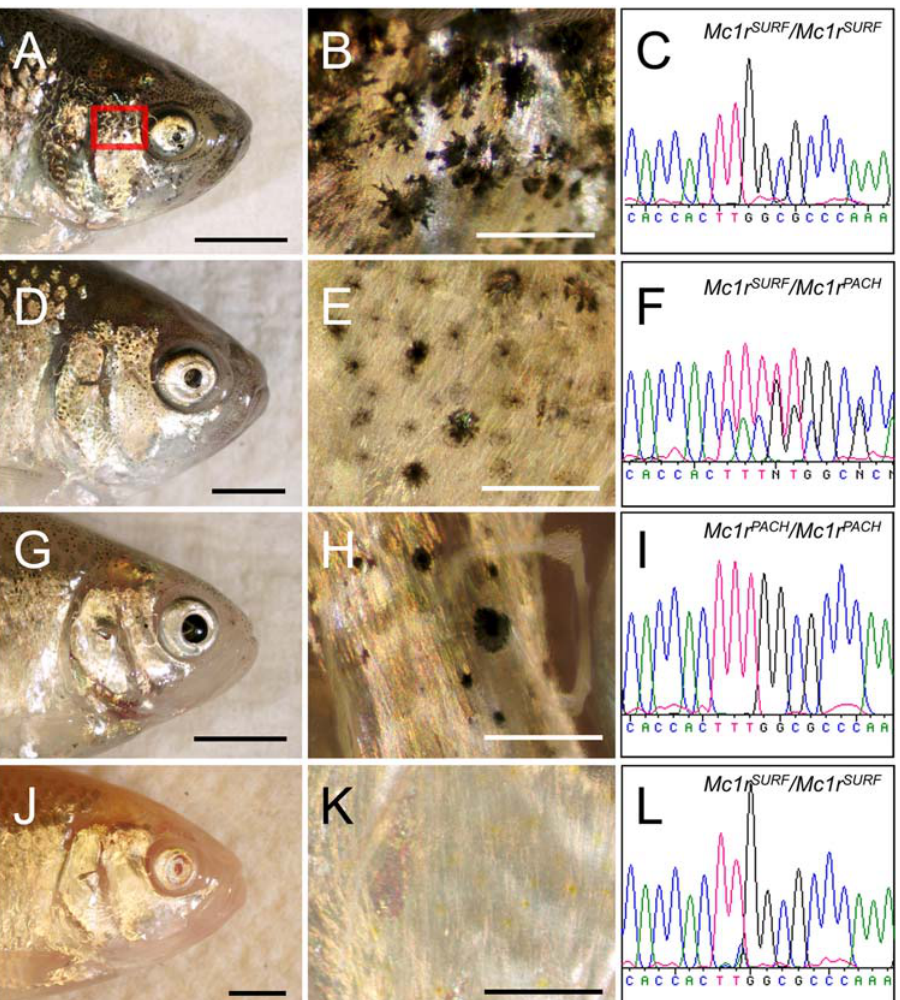
Figure 4. Mc1r genotype-phenotype correlation in representative members of an F 2 pedigree derived from a Surface 6 Pacho´n cavefish cross. (A,D,G,J) We crossed two F 1 hybrid individuals to generate a small pedigree of individuals demonstrating a range of pigmentation phenotypes. (A) Each fish was photographed from the right side to visualize the entire head or a region just posterior to the orbit of the eye (red rectangle). Each individual was also genotyped for the polymorphic region of Mc1r ORF housing the fixed 2-bp deletion found in members of the Pacho´n cave. (C,F,I,L) The resulting chromatogram sequence data is depicted to the right of each individual image. (A–C) We found that the darkest individual, with the most melanophores, carries two copies of the Surface form of Mc1r . (D–F) The heterozygous individual demonstrates roughly the same number of melanophores, however each cell appears to produce less eumelanin. (G–I) A non-albino F 2 individual with two copies of the Pacho´n allele of Mc1r demonstrates the least amount of pigmentation compare to other pigmented genotypes, however this individual clearly differs from (J) albino phenotypes. (J–L) An albino individual carrying two mutant copies of the gene Oca2 [1] who carries two Surface copies of Mc1r cannot produce pigment, demonstrating the epistatic nature of the albino mutation. Scale bars: A,D,G,J=3 mm; B,E,H,K=500 m m. the linkage group encompassing our QTL for melanophore number to the Danio rerio physical genome. We adapted the method of Stemshorn et al., 2005 [30] to analyze the genomic DNA sequences flanking our polymorphic microsatellites via BLAST searches against the latest version of the Danio rerio physical genome (Ensembl Assembly Zv7, Sanger Institute; www.